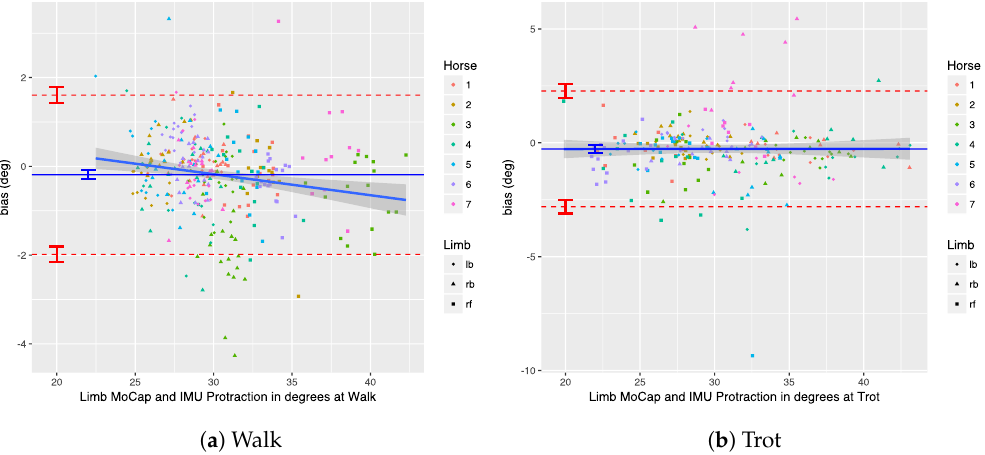
Figure 19. Bland–Altman analysis for protraction angles at walk and trot.